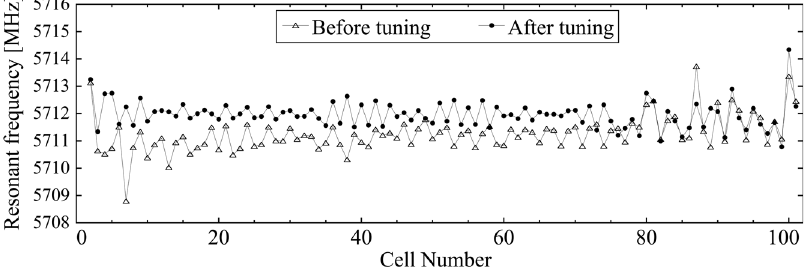
FIG. 8. Resonant frequency distribution along the individual accelerating cells before and after dimpling tuning. The curve with open triangles represents the result before tuning, and the curve with solid circles represents the result after